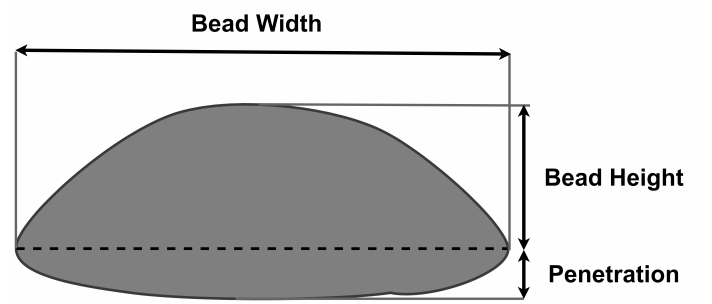
Figure 2. Half-ellipsoidal form of the bead